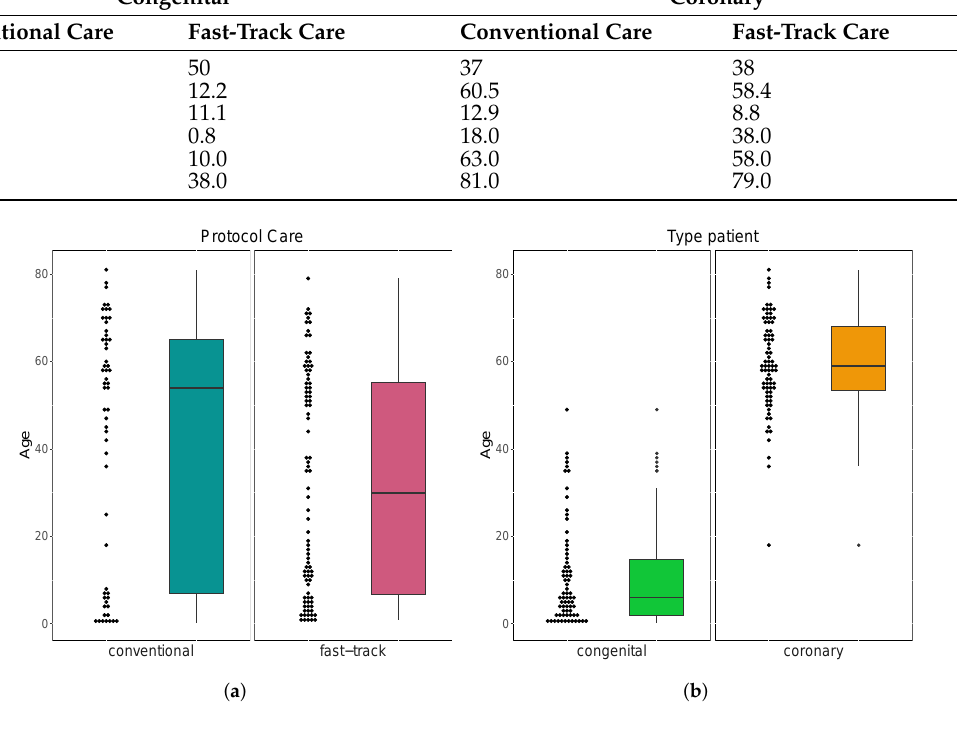
Figure 4. Box plots of age by protocol care ( a ) and type of patient ( b ).